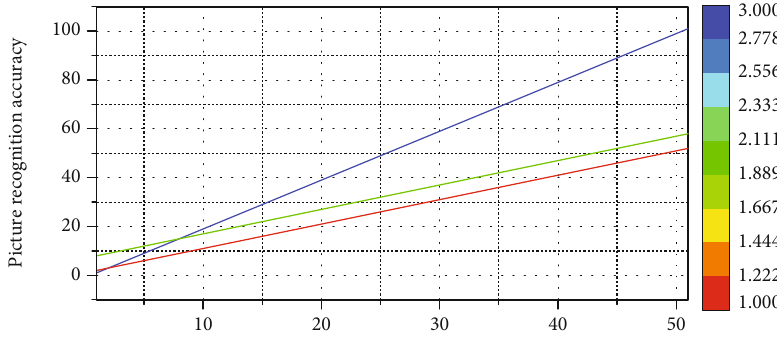
Figure 6: Accuracy of image recognition based on di ff erent algorithms.